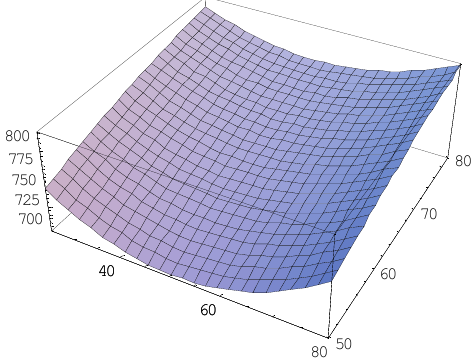
Fig. 2. Convexity of the T.A.C. function